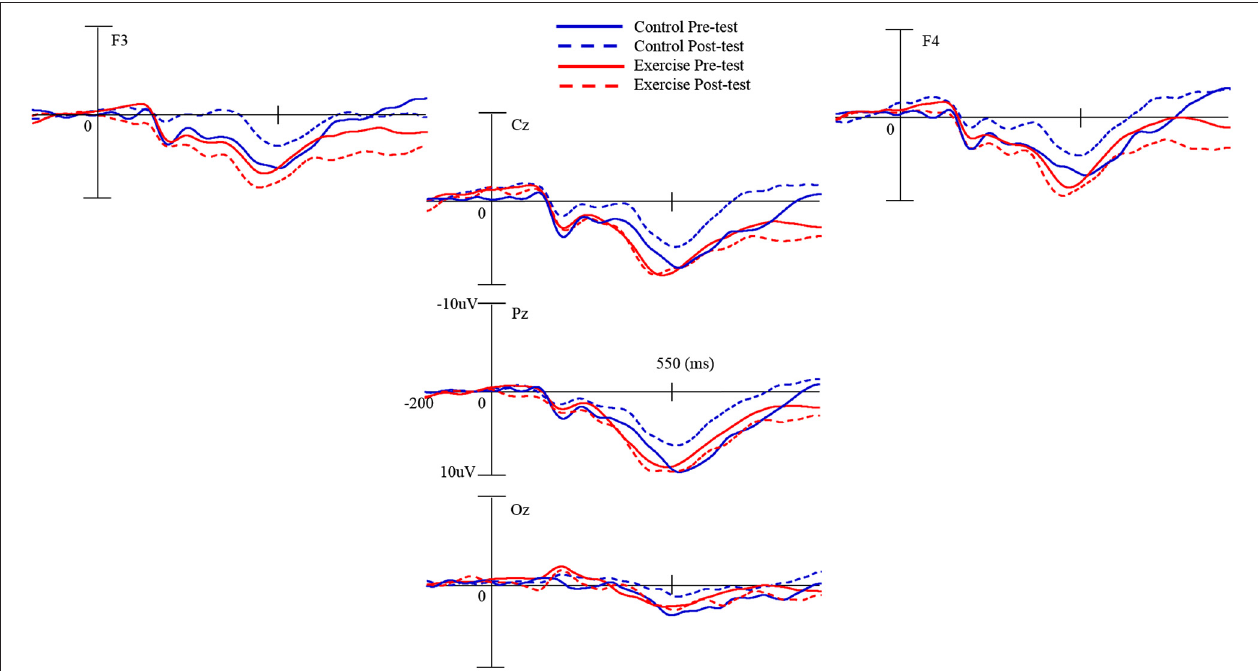
FIGURE 3 | Grand average event-related potential waveforms of five electrodes (F3 and F4 for the P3a component; Cz, Pz, and Oz for the P3b component) in the oddball condition during pre- and post-tests of exercise and control groups .